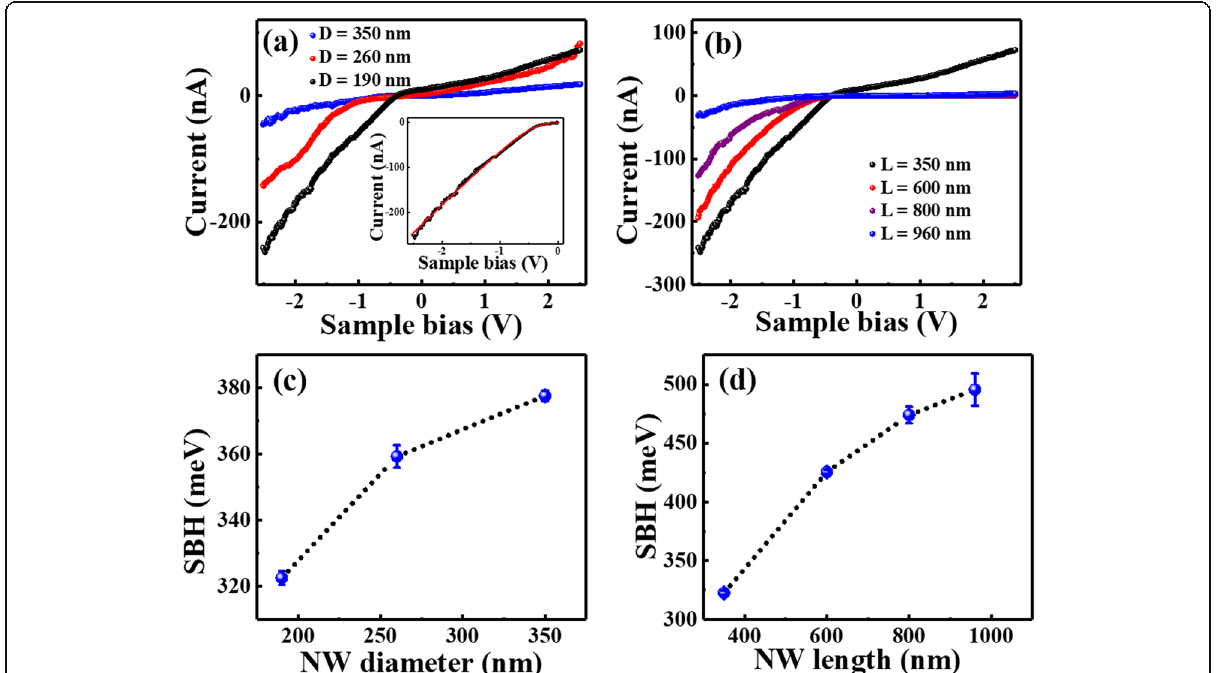
Fig. 6 Typical I-V curves on the Si NWs with the same length of 350 nm but different diameters ( a ) and same diameter of 190 nm but different lengths ( b ). The inset in a shows a typical fitting result of Si NWs with the diameter of 190 nm and length of 350 nm. c and d represent the Schottky barrier heights obtained from the fitting results as a function of NWs ’ diameter and length,